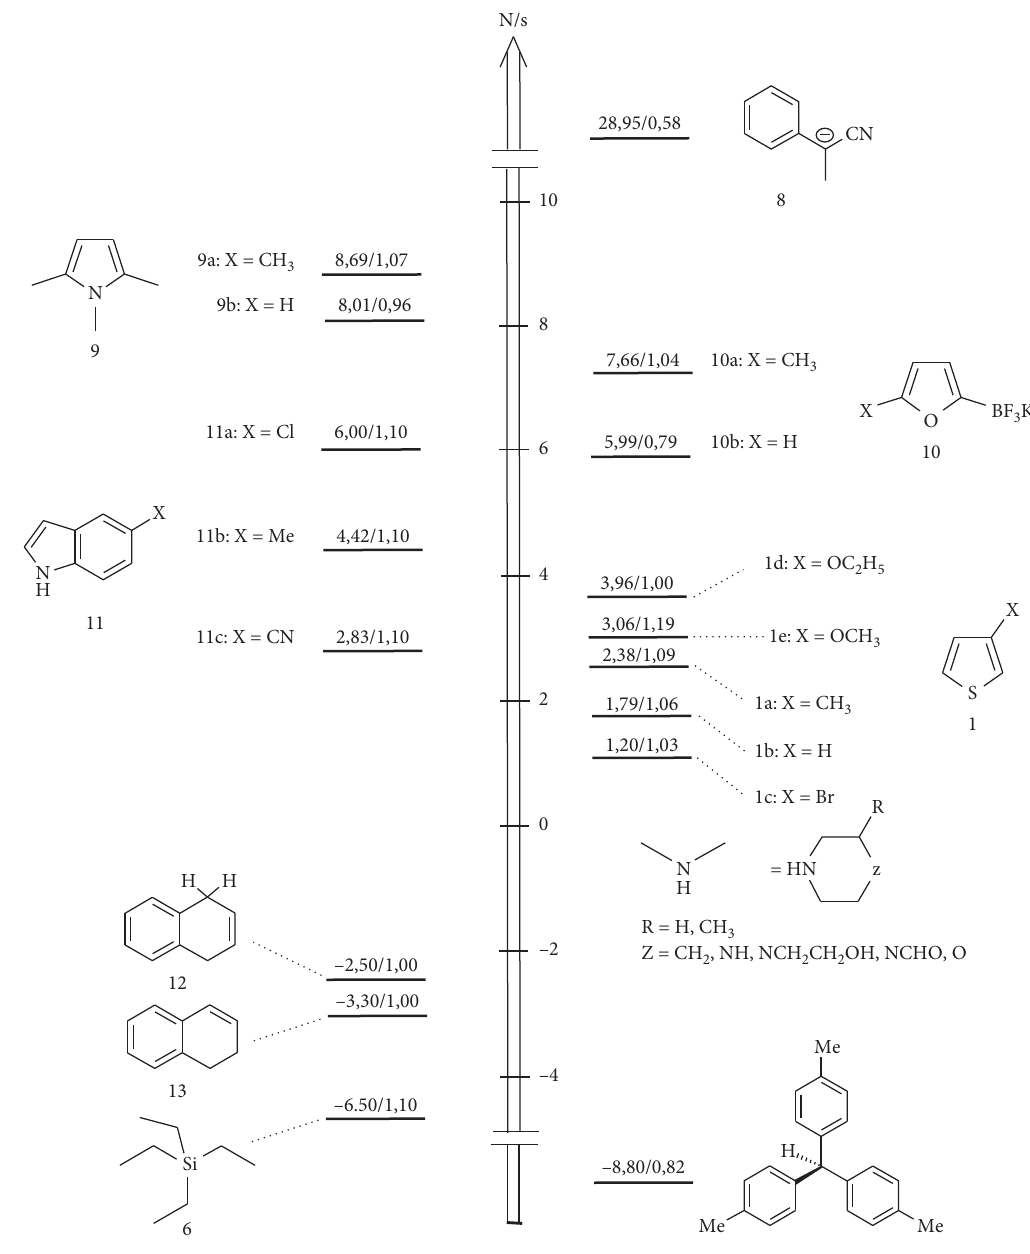
Figure 4: Ranking the carbon reactivity of the 3-X-substituted thiophene 1 on the Mayr N universal N